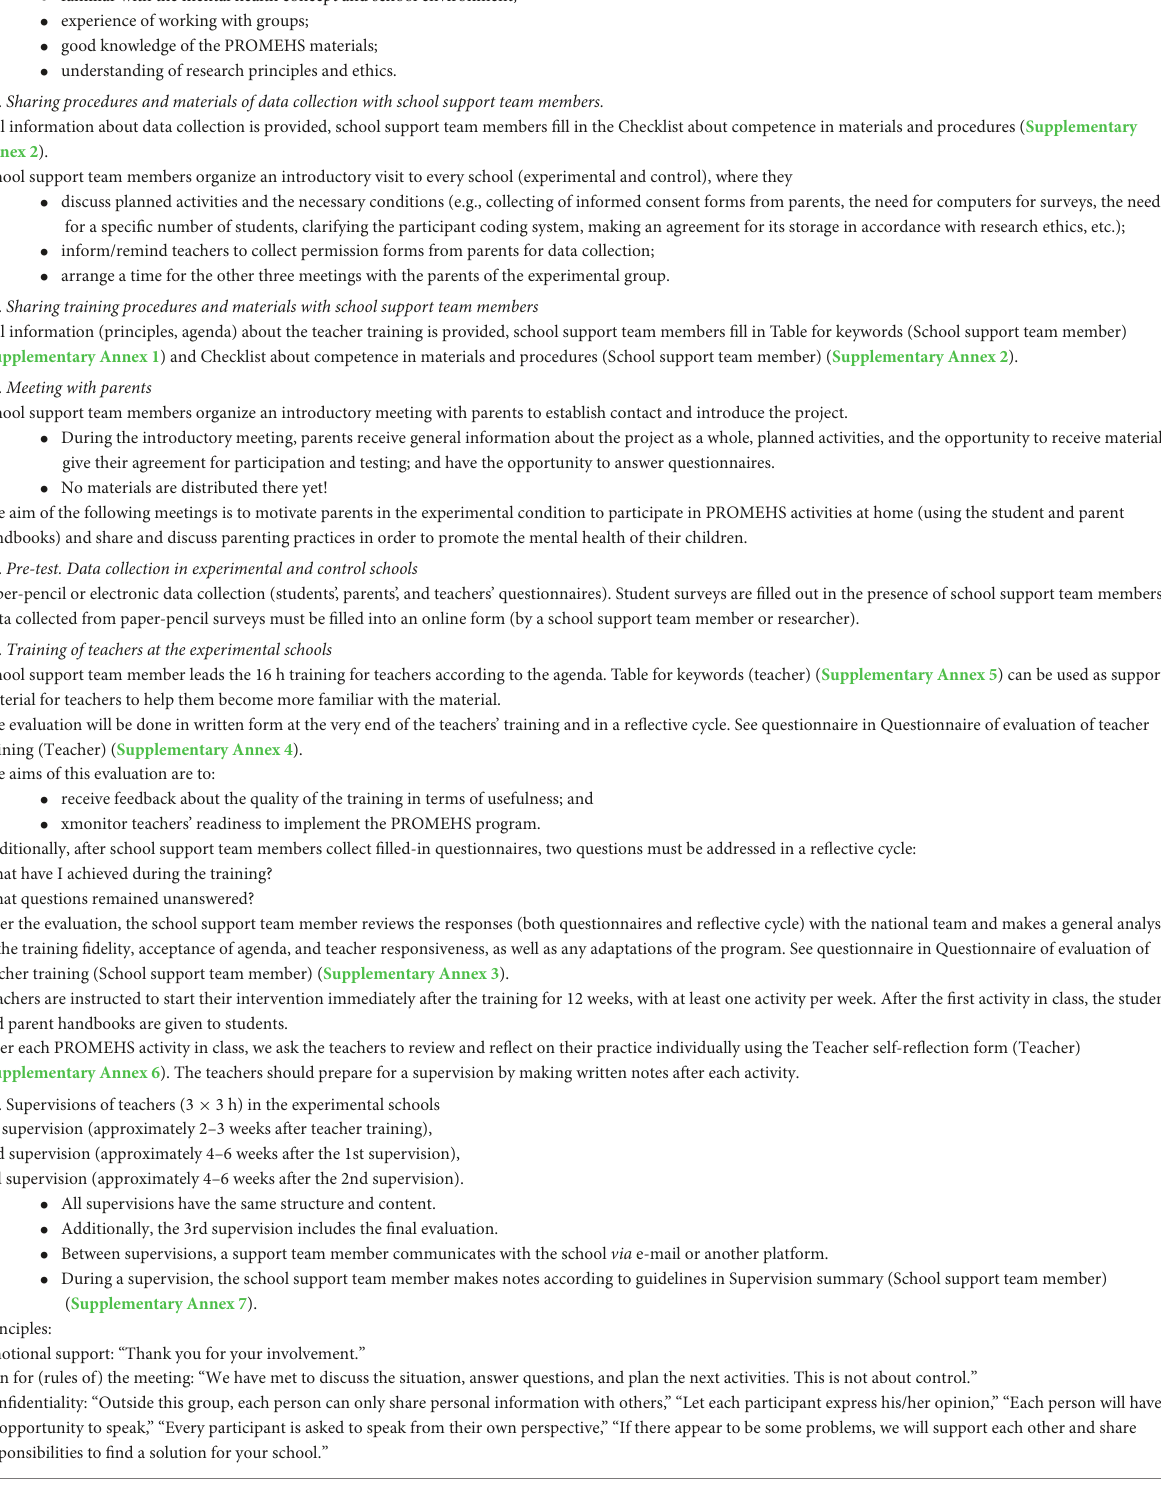
TABLE 3 The Promoting Mental Health at Schools (PROMEHS) monitoring